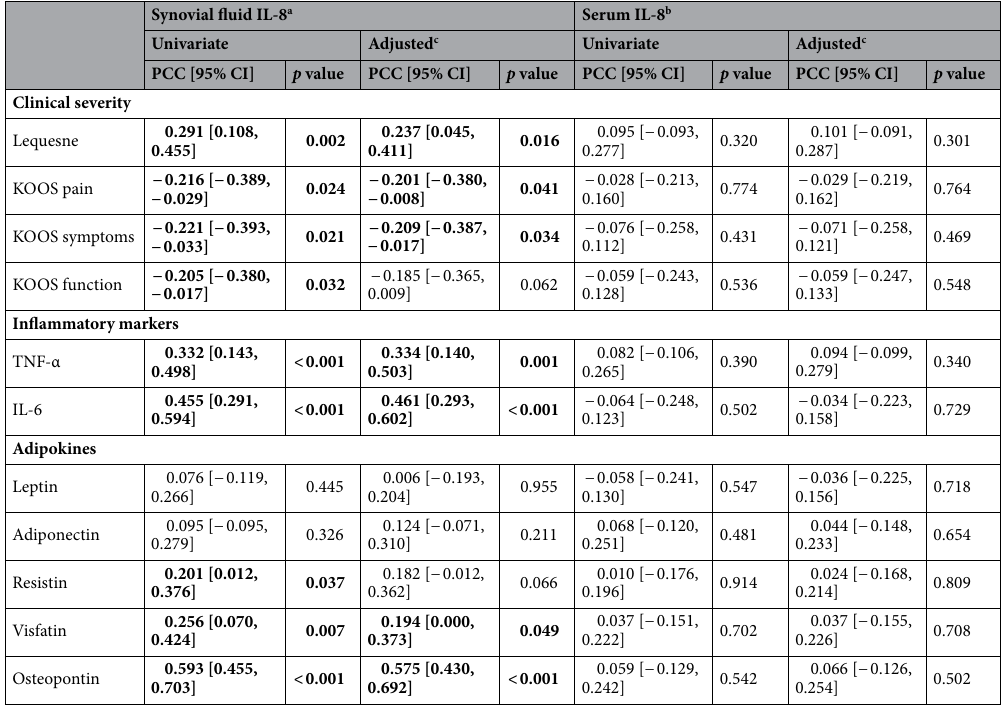
Table 2. Synovial fluid and serum IL-8 associations with clinical severity, inflammatory markers and adipokines in synovial fluid and blood. a Synovial fluid associations between IL-8 with inflammatory markers and adipokines. b Serum associations between IL-8 with inflammatory markers and adipokines. KOOS Knee injury and Osteoarthritis Outcome Score, SF synovial fluid, IL-8 interleukin-8, IL-6 interleukin-6, TNF-α Tumor Necrosis Factor-alpha. c Effects adjusted by measurement batch and by potential confounders: age, OA evolution time, KL grade and BMI. KL Kellgren–Lawrence scale, BMI Body Mass Index. Statistical significant associations are in bold type. PCC partial correlation coefficient. 95% CI interval at 95% confidence. Statistically significant results are highlighted in